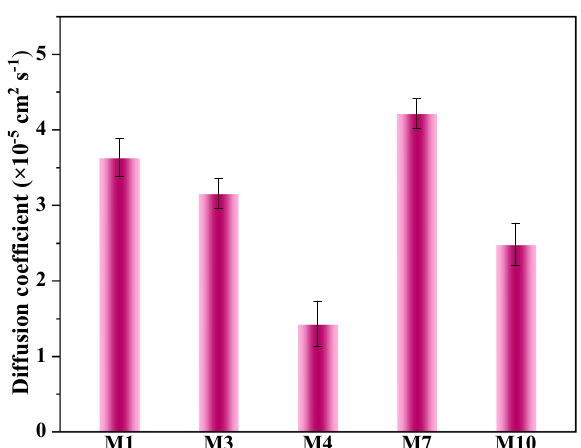
Fig. 11 Stress-strain curves of the typical unaged and aged PDMS models in simulation and the pure PDMS in experiment.